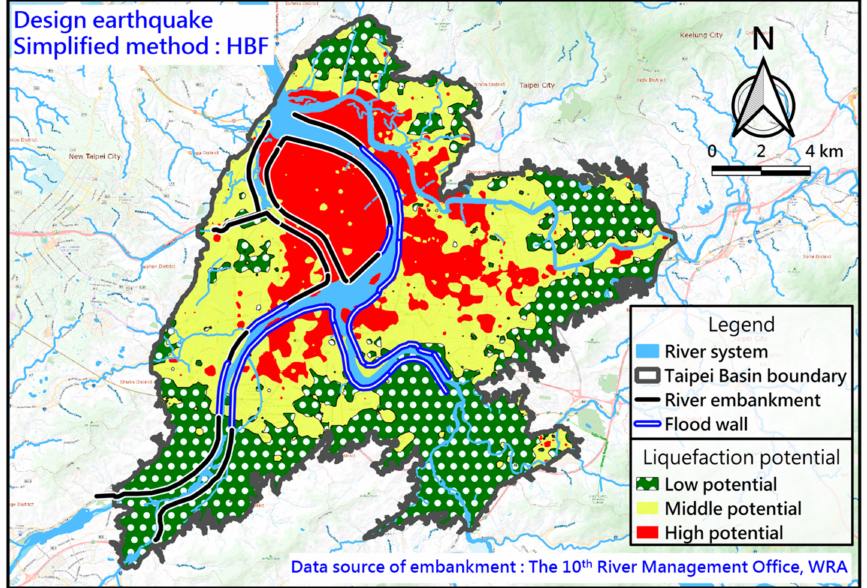
Figure 2. The distribution of river embankments and liquefaction potential in the Taipei